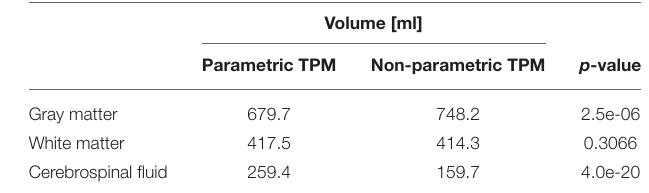
FIGURE 8 | The templates in the columns: All, Men, Women, Young, and Old. In the rows: the registration targets of T1 and T2 and the templates for GM, WM, and CSF.